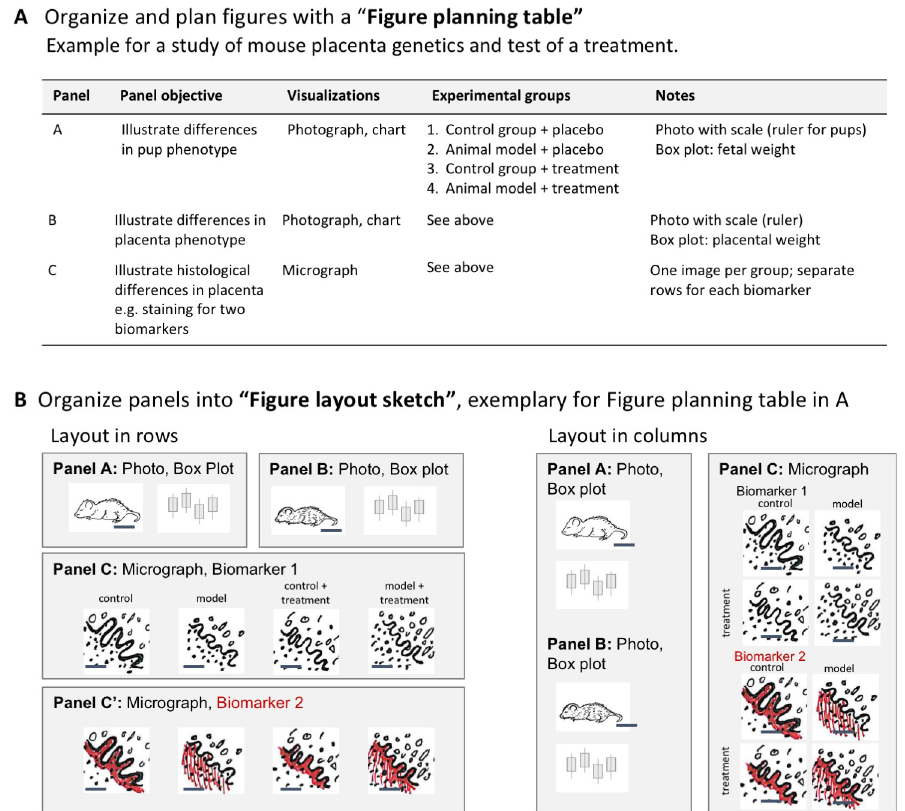
Fig 9. Planning multipanel figures. Planning tables and layout sketches are useful tools to efficiently design figures that address the research question. ( A) Planning tables allow scientists to select and organize elements needed to answer the research question addressed by the figure. ( B) Layout sketches allow scientists to design a logical layout for all panels listed in the planning table and ensure that there is adequate space for all images and graphs.